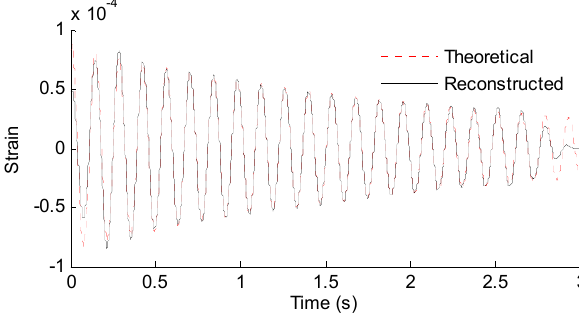
Figure 10. Reconstructed and theoretical strain responses for the location of interest shown in Figure 7.